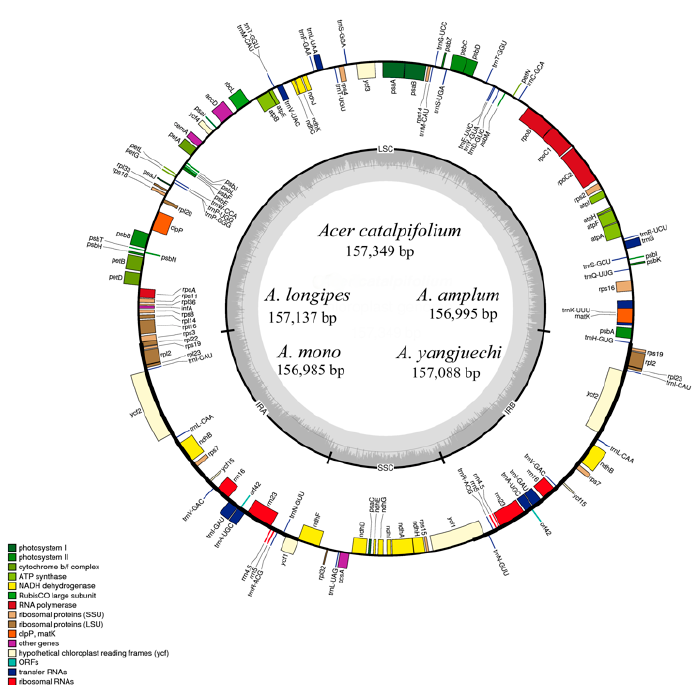
Figure 1. Merged gene map of the complete chloroplast genomes of five Acer sect. Platanoidea species. Genes belonging to different functional groups are colour-coded. The genes drawn inside the circle are transcribed clockwise, while those outside are transcribed counter-clockwise. Darker grey in the inner circle corresponds to the GC content of the chloroplast genome. Table 2. Genes presented in the Acer sect. Platanoidea chloroplast Table 1. General features of the Acer sect. Platanoidea chloroplast genomes compared in this study.